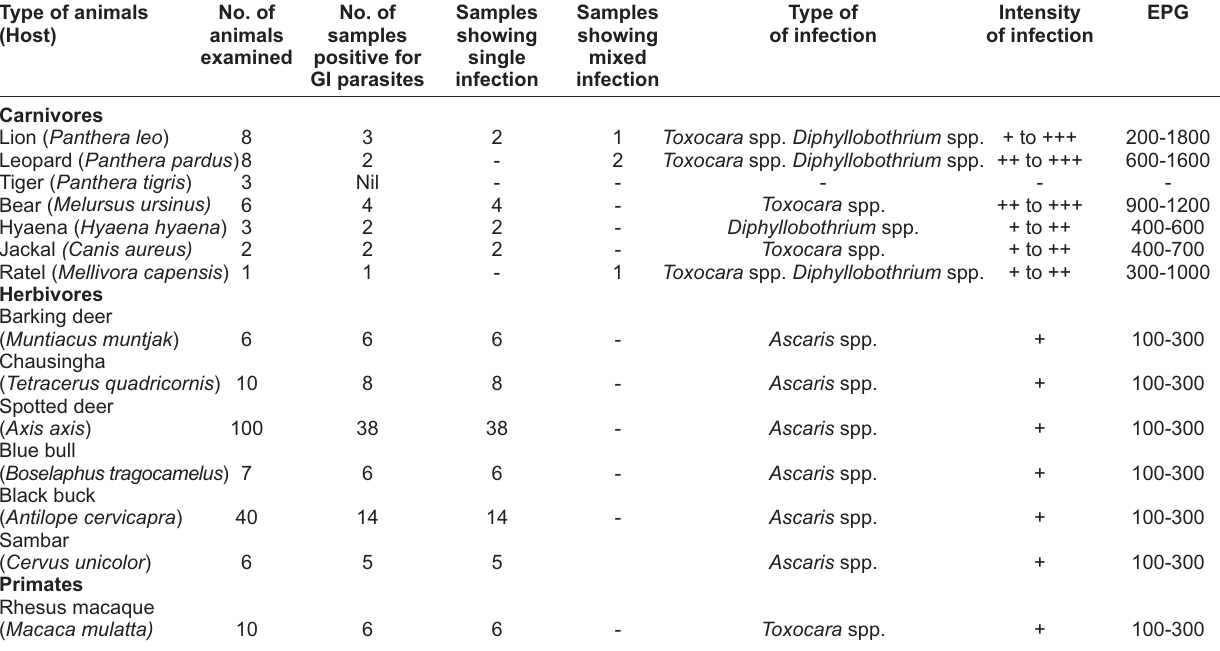
Table-1: Prevalence of gastro-intestinal parasitic infection in captive wild animals of Nandan Van Zoo, Raipur Type of animals No.